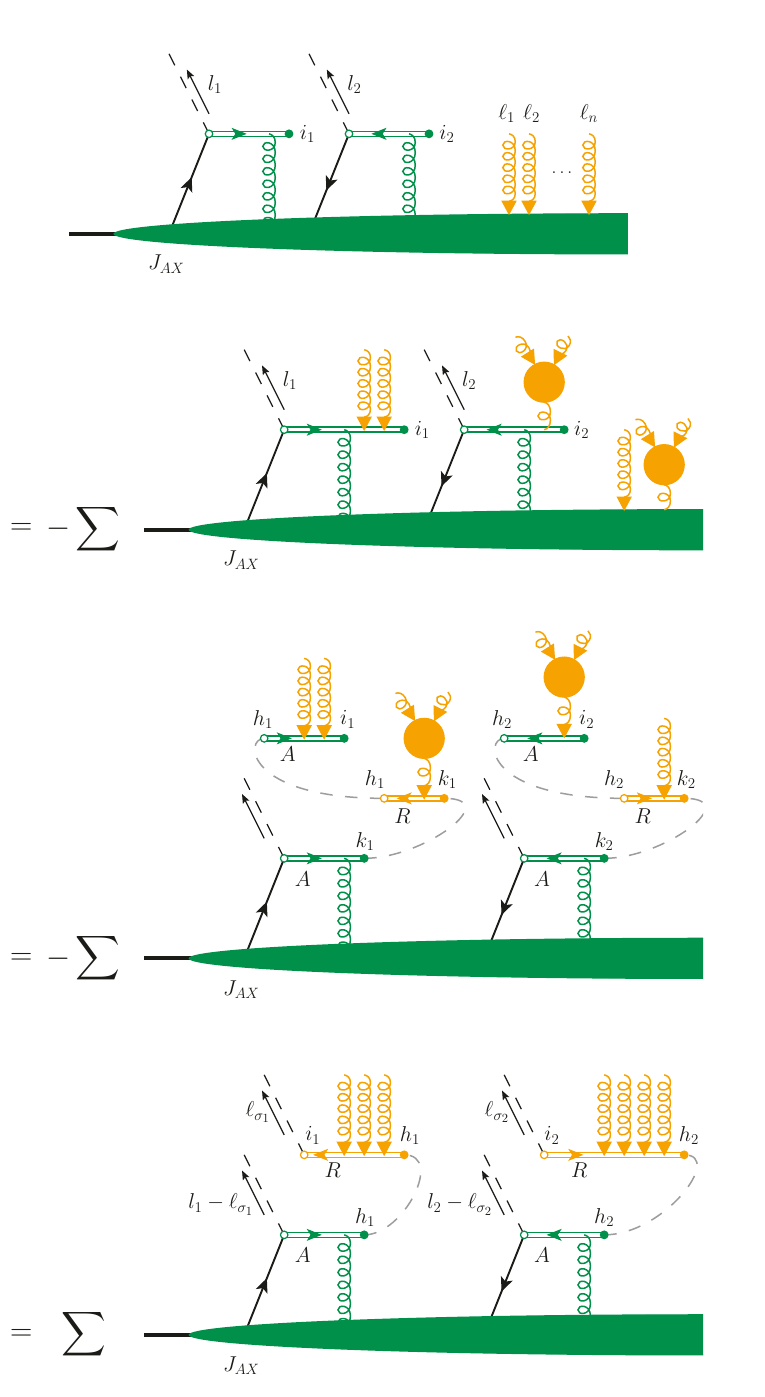
Figure 11 . Decoupling of n soft gluons from a collinear graph in the amplitude of a DPS process. The sums over di(cid:11)erent possibilities in the last three steps are speci(cid:12)ed in the text.